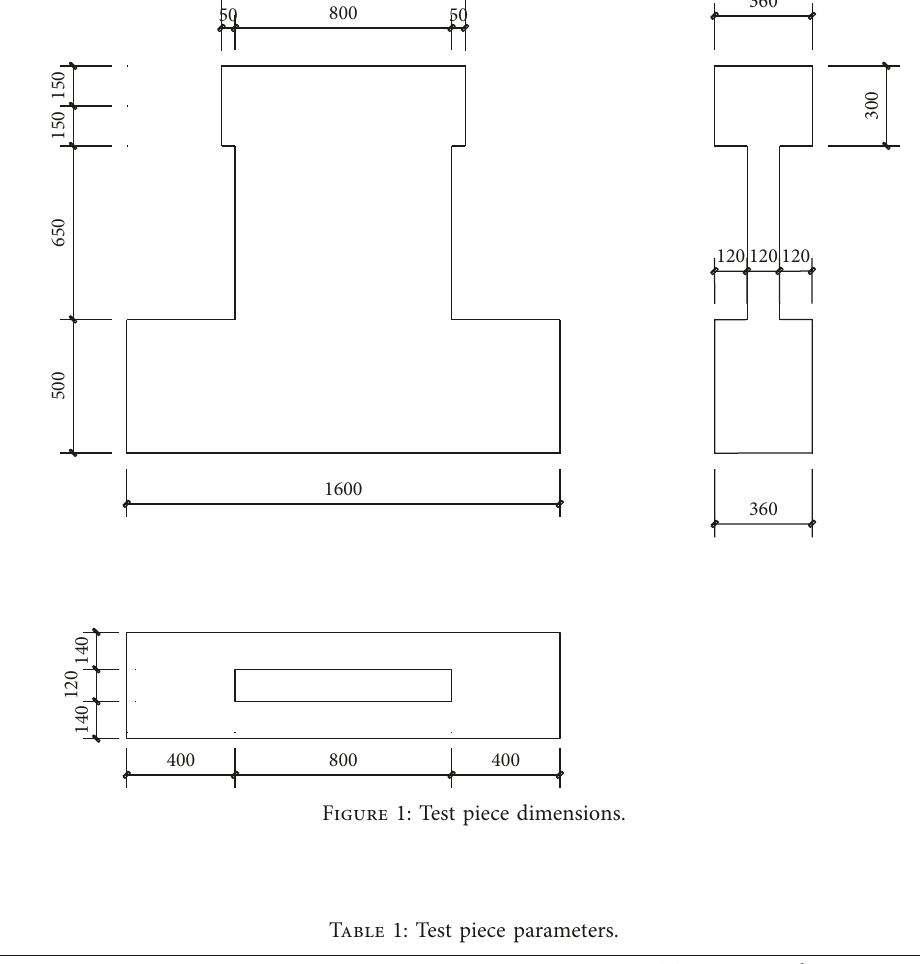
Figure 1: Test piece dimensions.